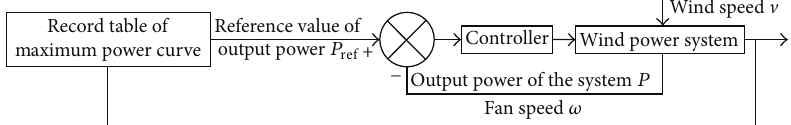
Figure 5: Block diagram of power curve control.